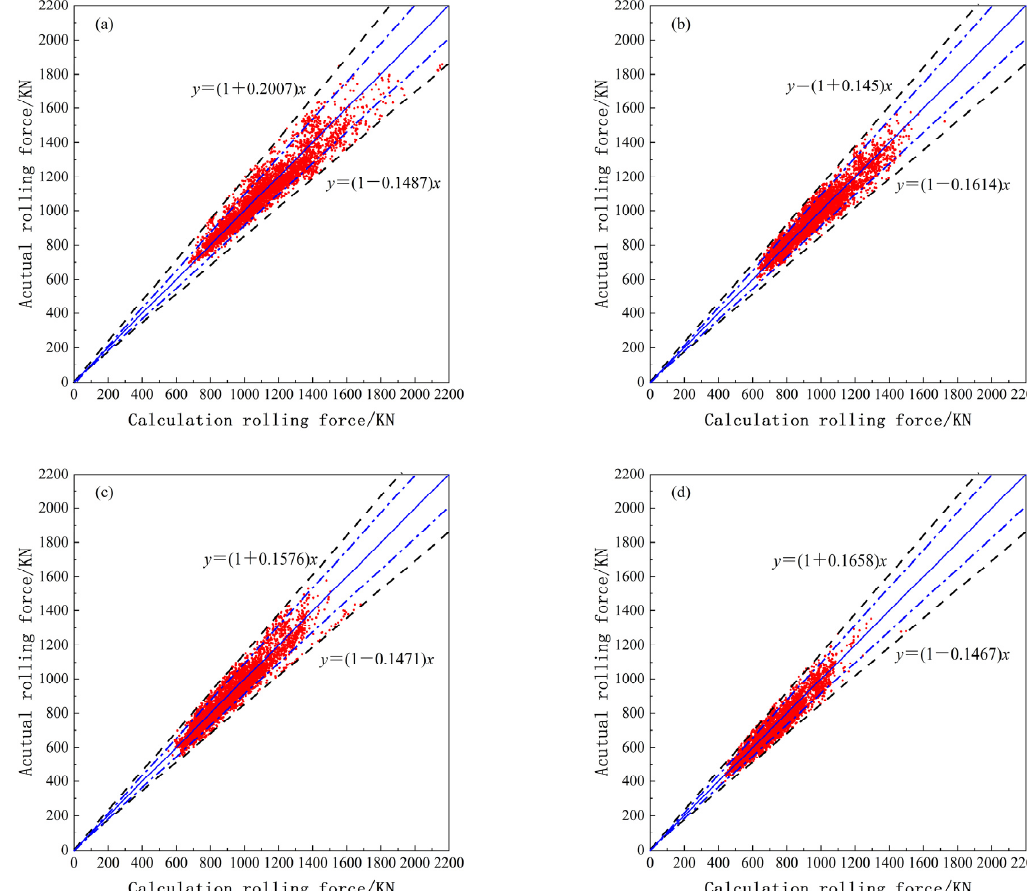
Figure 7. Rolling force calculation results distribution after optimizing the friction coefficient model: ( a ) S1 stand ( b ) S2 stand ( c ) S3 stand ( d ) S4 stand.